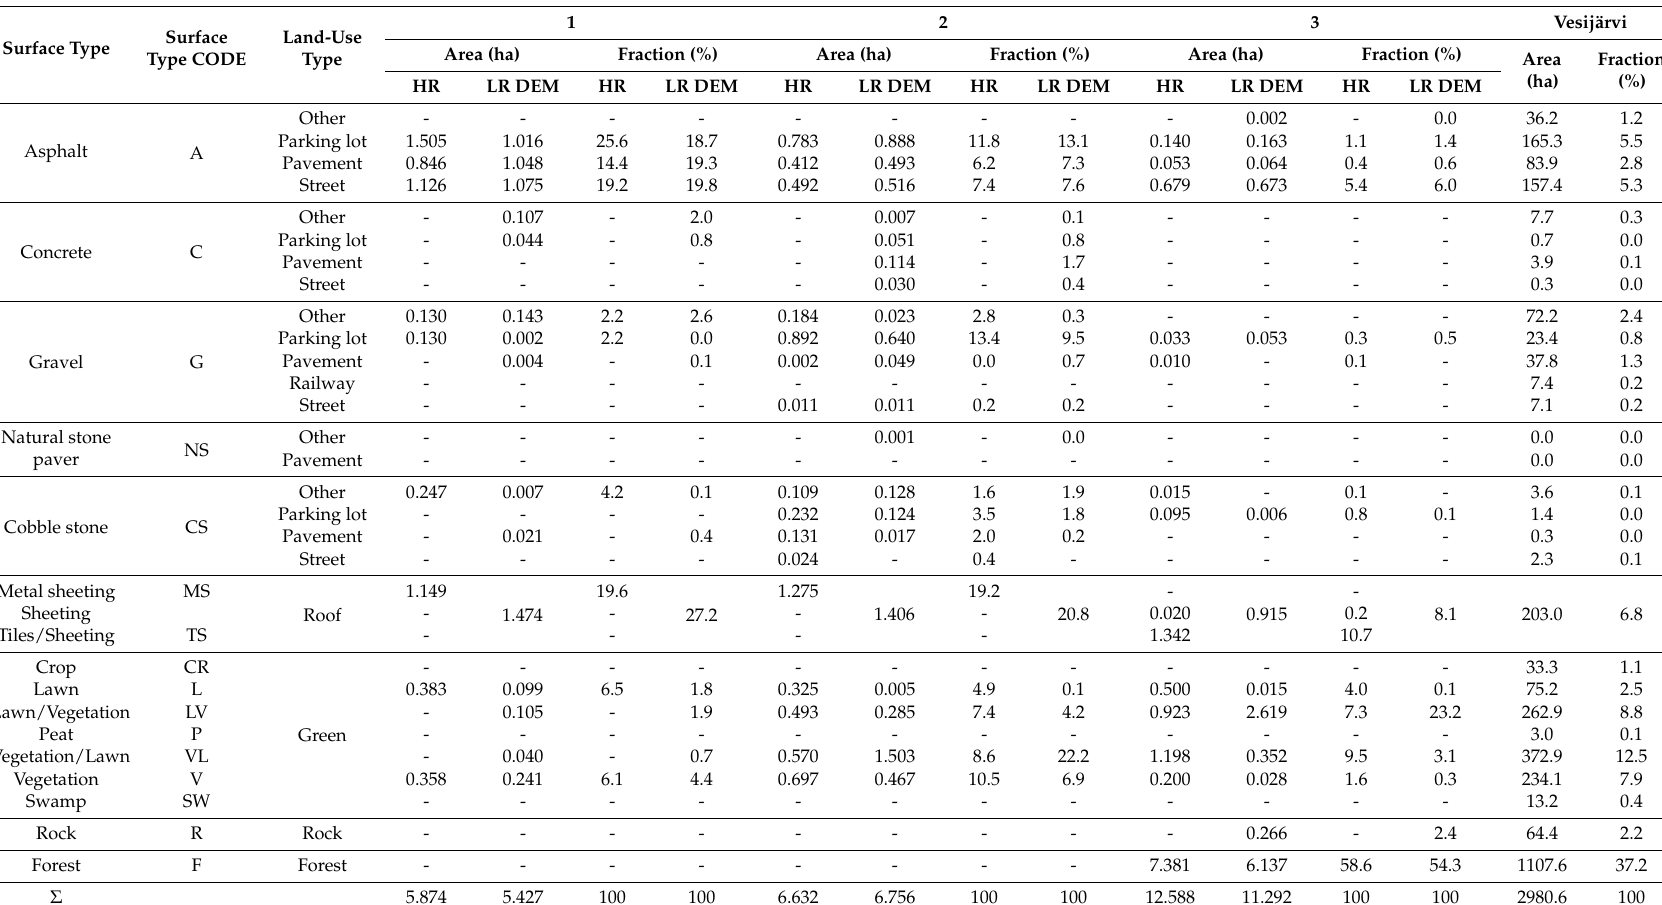
Table 1. Surface and land-use types and their fractions of the catchment for HR and LR-DEM models of the study catchments 1, 2, and 3, and for the Vesijärvi catchment.